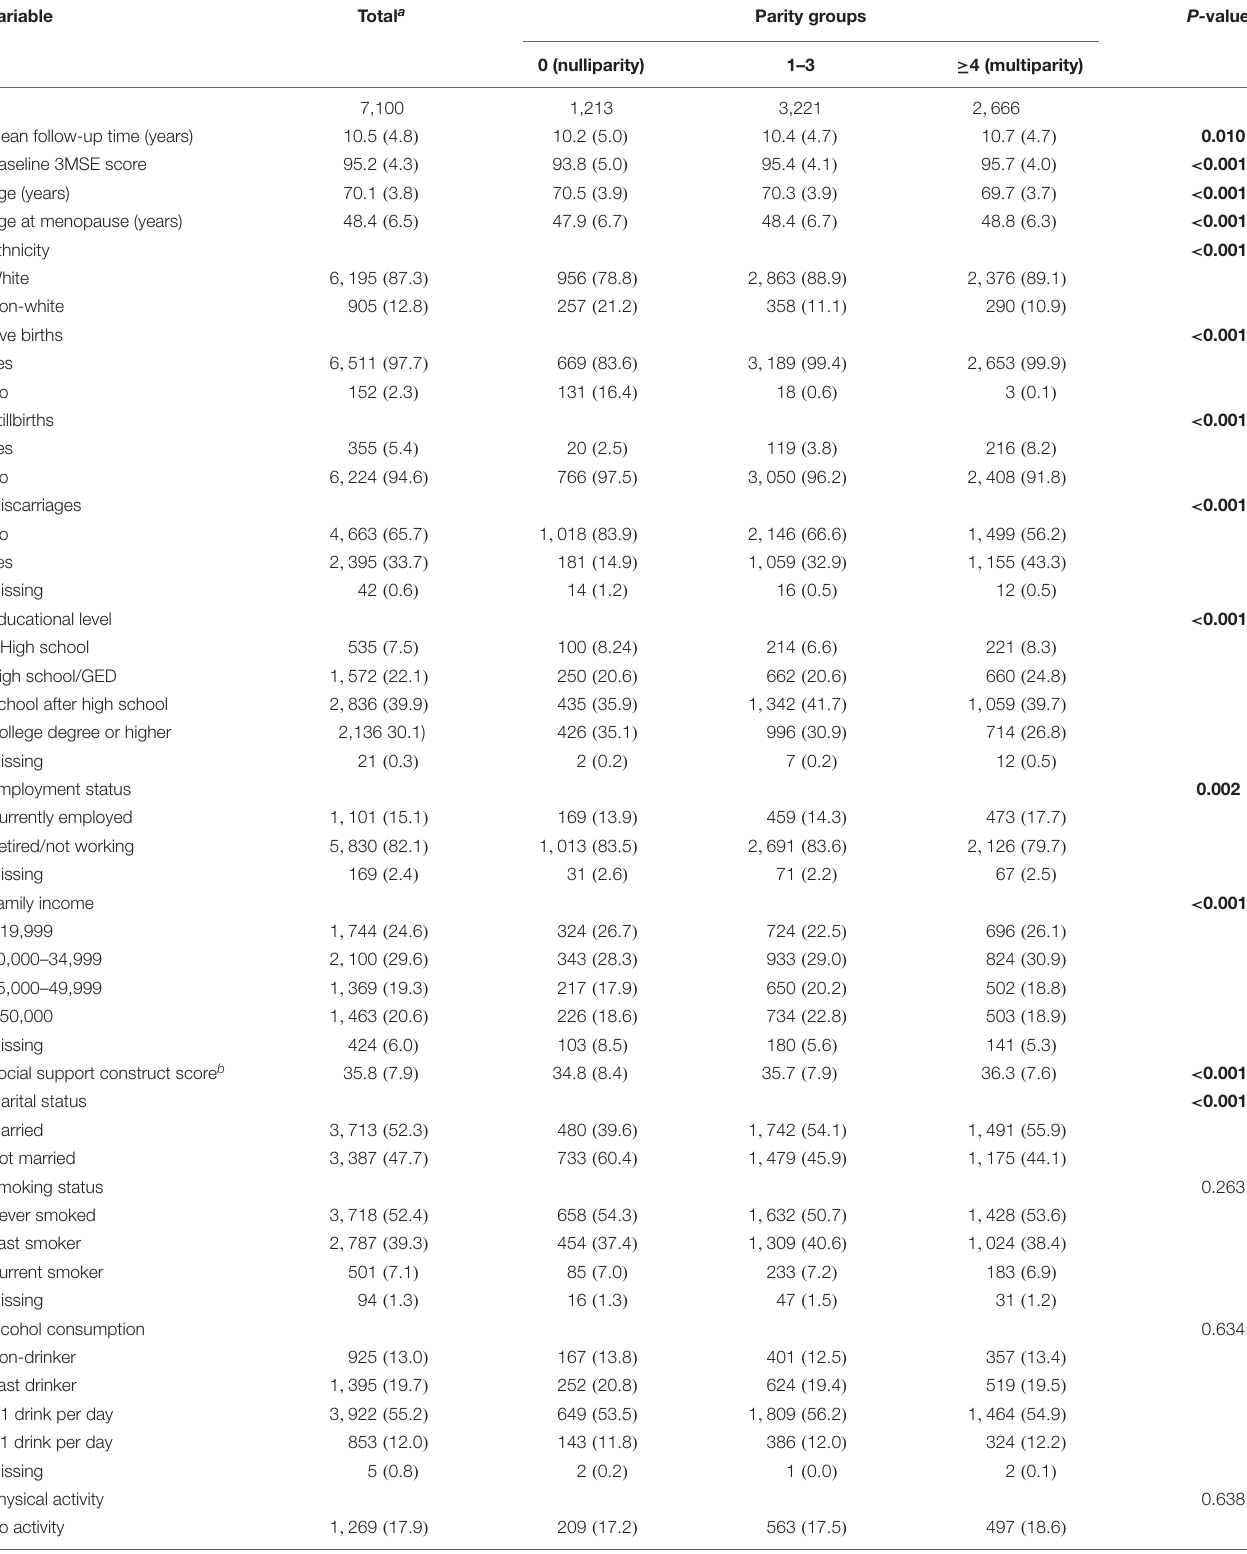
TABLE 1 | Baseline characteristic of 7,100 WHIMS participants between parity groups.